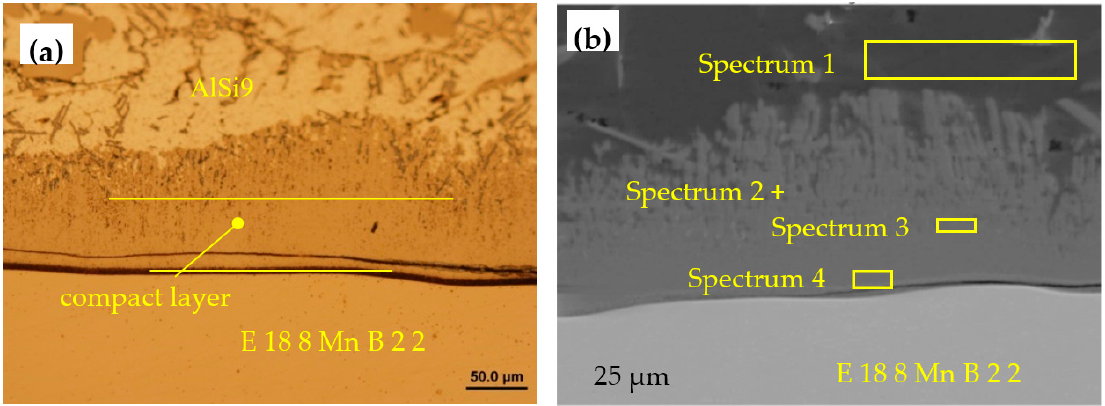
Figure 20. E 18 8 Mn B 2 2/680 ± 20 °C/300 min/AlSi9. Intermetallic compounds at boundary between the E 18 8 Mn B 2 2 deposit and the solidified aluminum alloy melt ( a ). EDX semi-quantitative microanalyses ( b ).